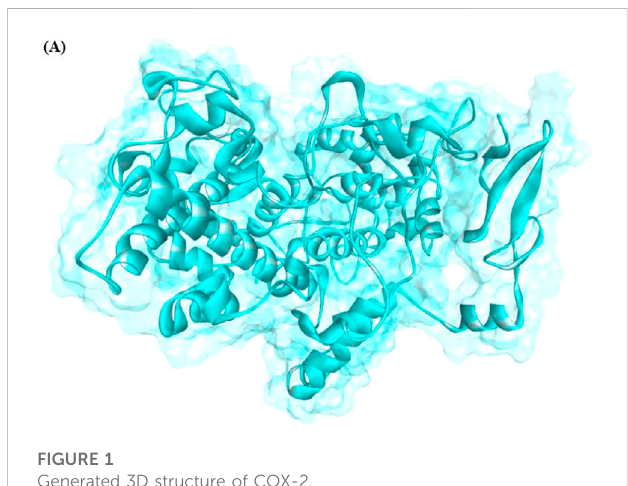
FIGURE 1 Generated 3D structure of COX-2.